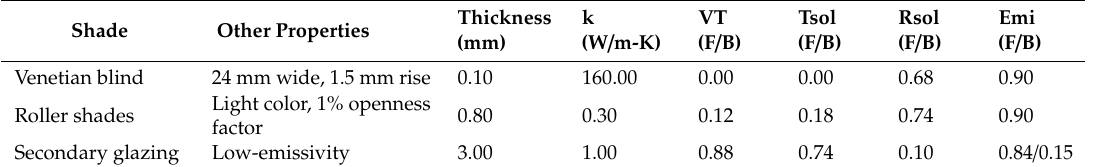
Table 1. Properties of shading devices and secondary